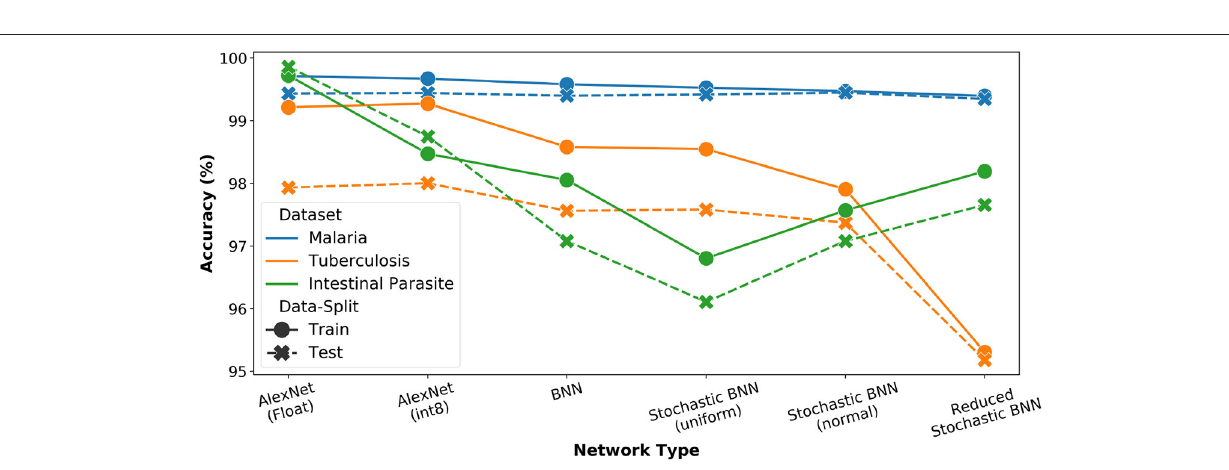
FIGURE 7 | Network precision and architecture analysis for microscopy diagnosis task. For all stochastic networks, training and inference is performed with N pre = 32.